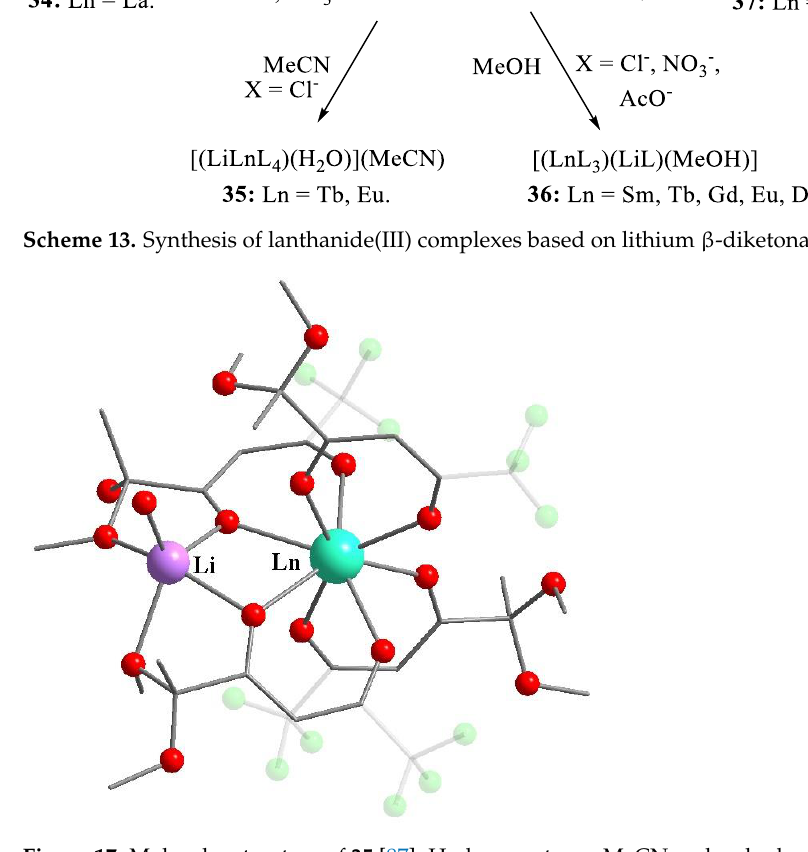
Figure 17. Molecular structure of 35 [87]. Hydrogen atoms, MeCN molecules have been omitted, CF 3 groups are transparent for clarity. The cif has been retrieved from CCDC. CCDC numbers are 1973632 (Ln = Eu), 1973633 (Ln = Tb).